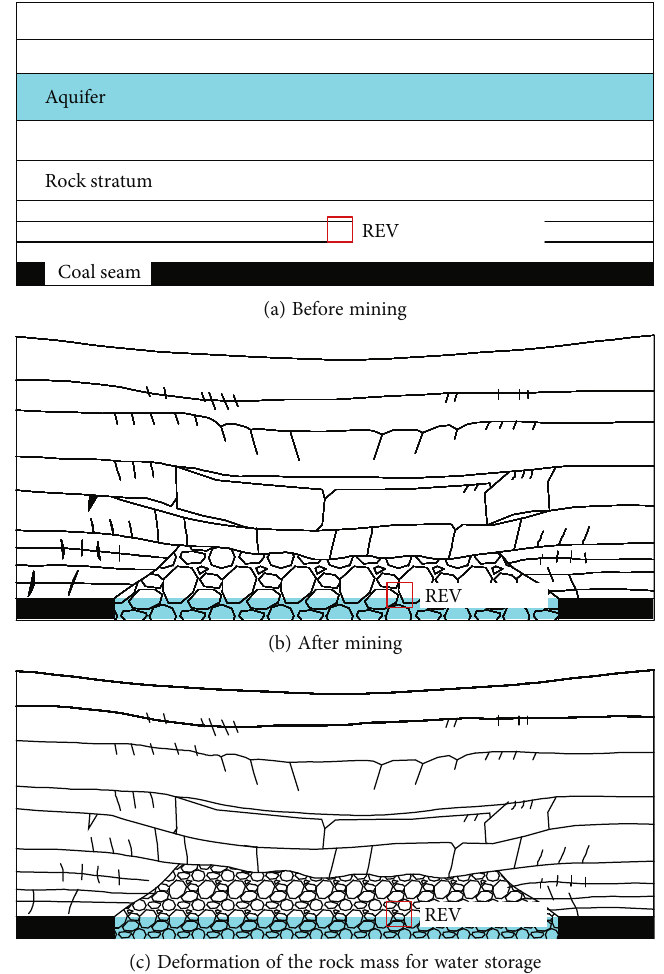
Figure 2: Evolution of the water storage media in the underground reservoir of a coal